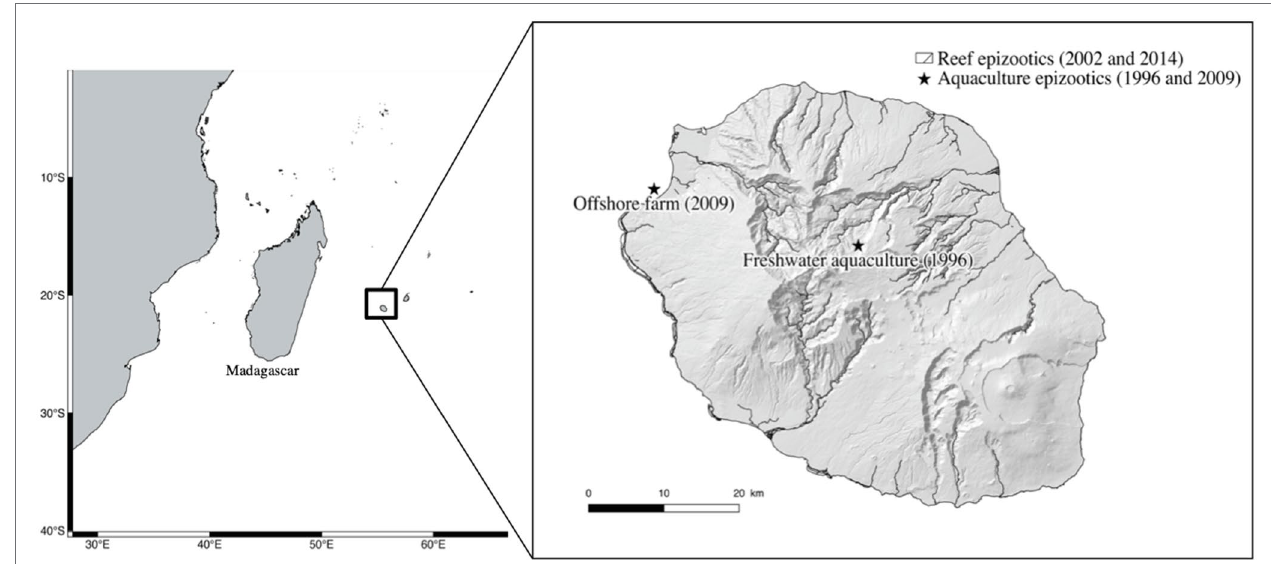
FIGURE 1 | Map of the epizootics investigated on Reunion Island since 1996. Reef epizootics in 2002 and 2014 were spread along the West coast of the island on different coral